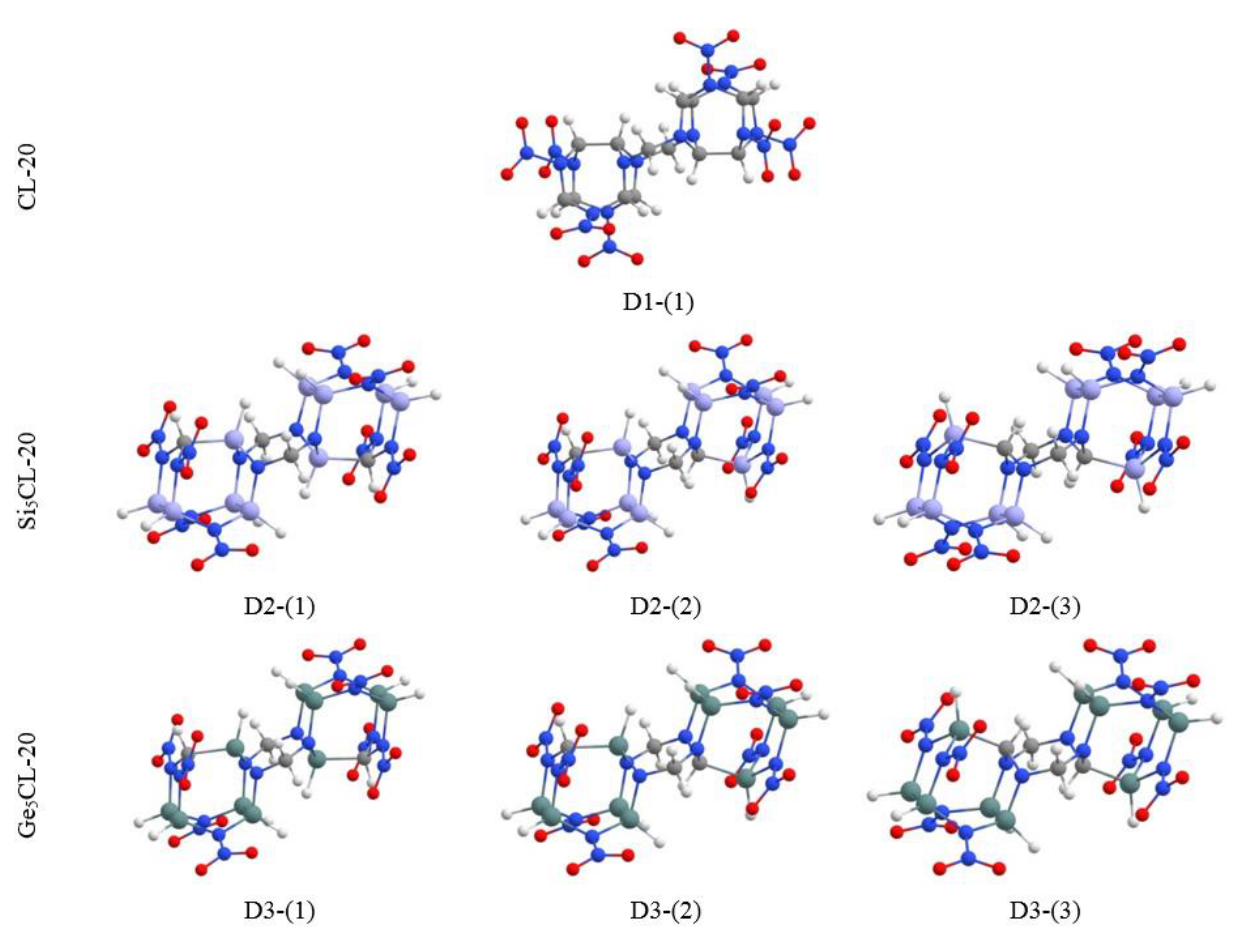
Figure 11. D1-(1)—the dimer of pure molecules CL-20; D2-(1), D2-(2), D2-(3)—the dimers of silicon Figure 11. D1-(1) — the dimer of pure molecules CL-20; D2-(1), D2-(2), D2-(3) — the dimers of silicon molecules Si 5 CL-20; D3-(1), D3-(2), D3-(3) — the dimers of germanium molecules Ge 5 CL-20. molecules Si 5 CL-20; D3-(1), D3-(2), D3-(3)—the dimers of germanium molecules Ge 5 CL-20. The values of the binding energy E b obtained for the dimers are presented in Table 4. Table 4. The binding energies, HOMO – LUMO gaps, ε H and ε L energies of the dimers based on CL- 20, Si 5 CL-20, and Ge 5 CL-20 molecules obtained at the DFT/B3LYP/6-311(d,p) level of theory.